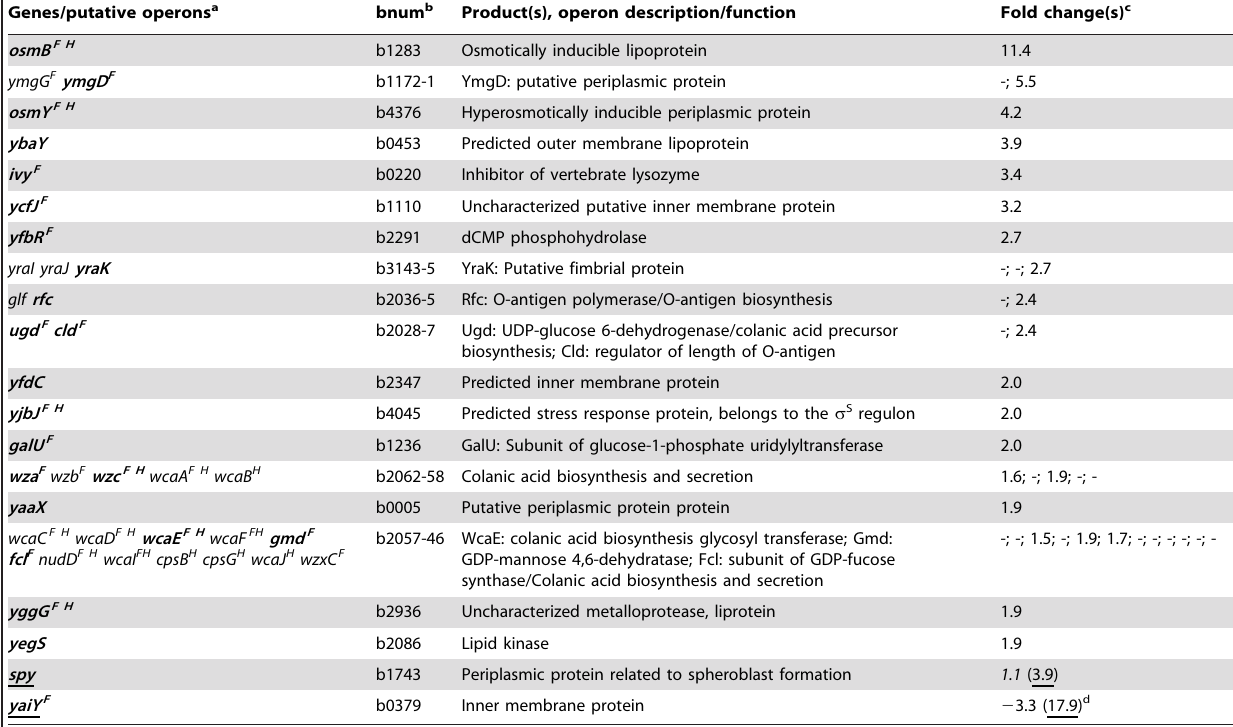
Table 3. Genes whose expression is significantly modulated by RcsB.